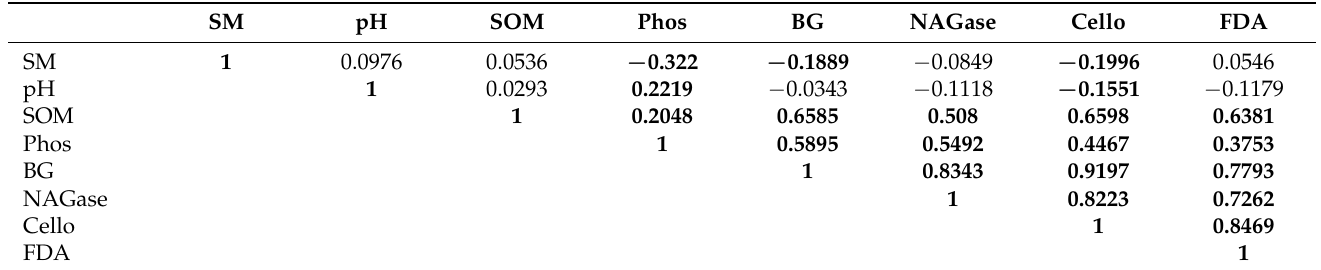
Table 3. Correlations between soil parameters during the study period